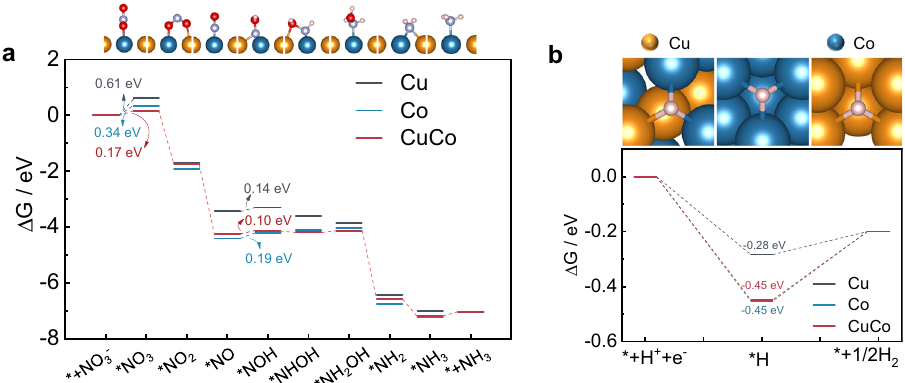
Fig.6|DFTcalculationsofNO 3 − RRandHERonCu(111),Co(111),andCuCo(111). Reaction-freeenergiesfordifferentintermediatesofNO 3 - RR( a )andHER( b )at − 0.2V vs. RHE on CuCo(111), pure Cu(111), and pure Co(111) surface,